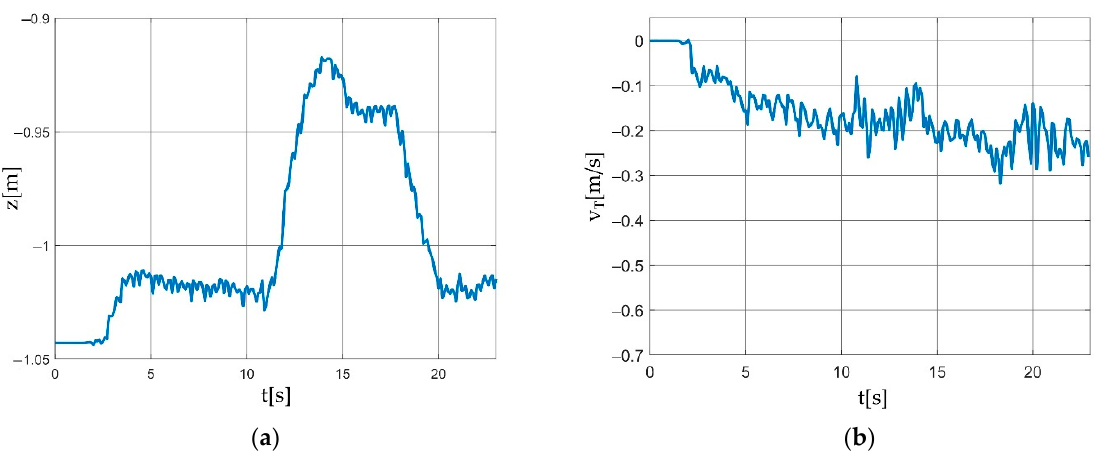
Figure 17. Graphs of ( a ) the course of the coordinate value on the OZ axis; ( b ) the velocity of the characteristic point of the GO1 robot with which the retroreflector is associated.